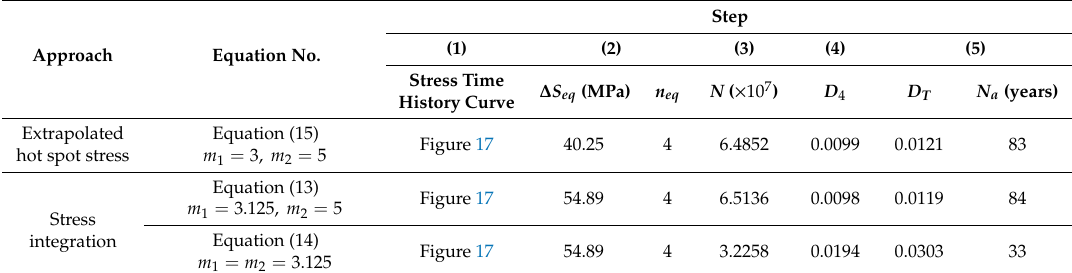
Table 4. Fatigue life calculation